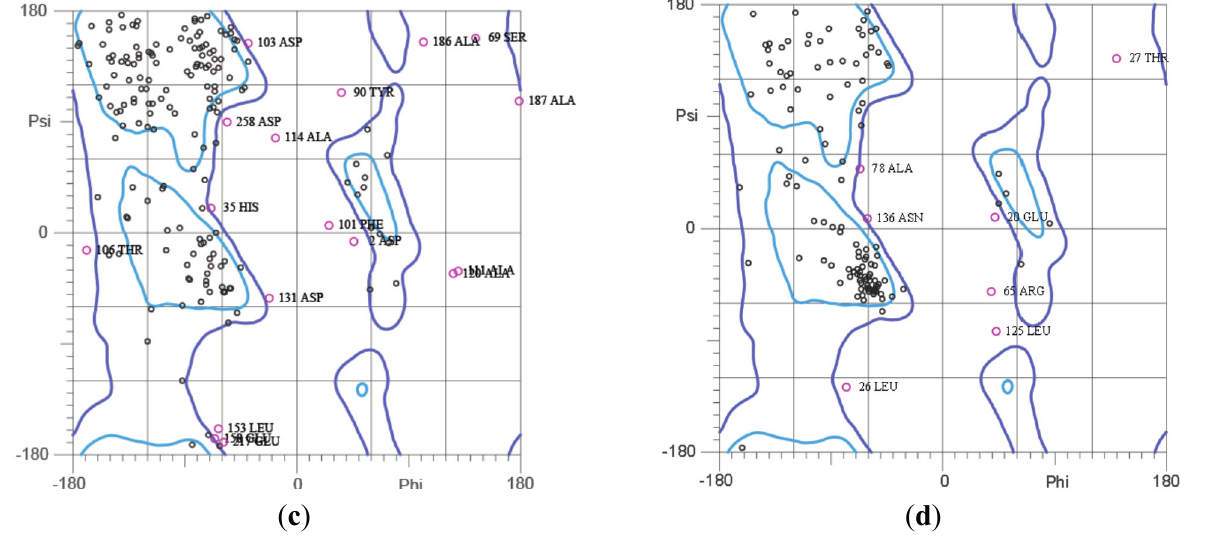
Figure 9. Ramachandran Plot Analysis (Ramachandran of I-TASSER MODEL structures predicted for ( a ) chrB_23 ( b ) pcoA_25 ( c ) pcoA_29 and ( d ) pcoR_29.